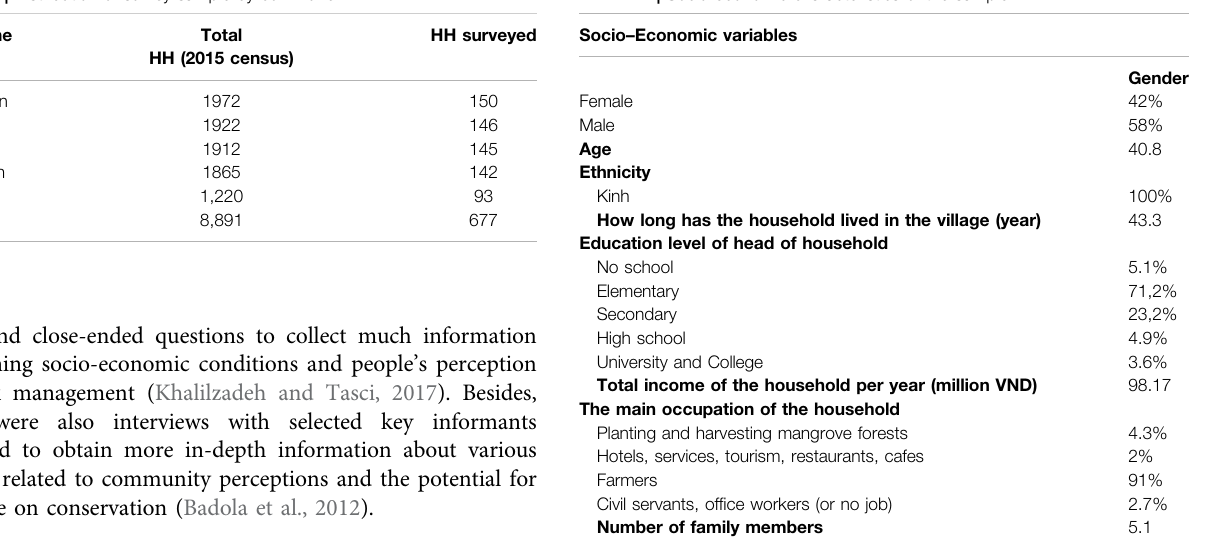
TABLE 1 | Distribution of survey sample by commune. TABLE 2 | Socio-economic characteristics of the